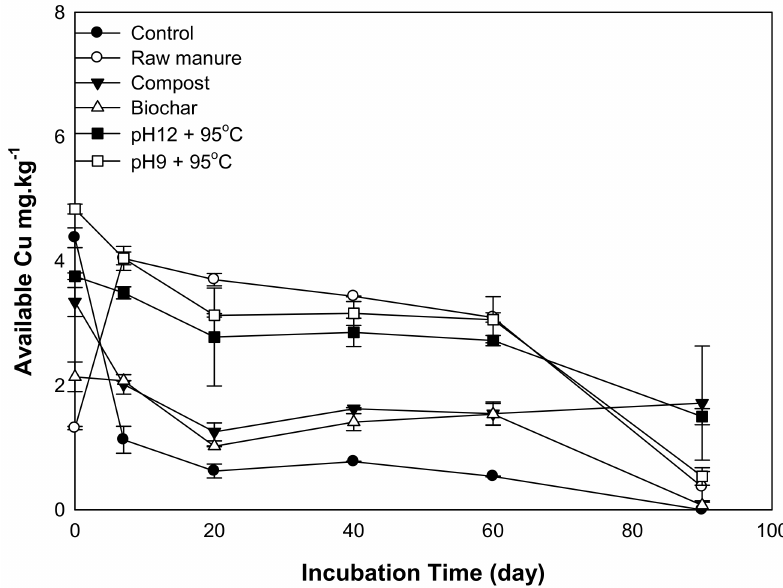
Figure 5. Soil available copper, affected by different organic amendments derived from cow manure at different incubation times.